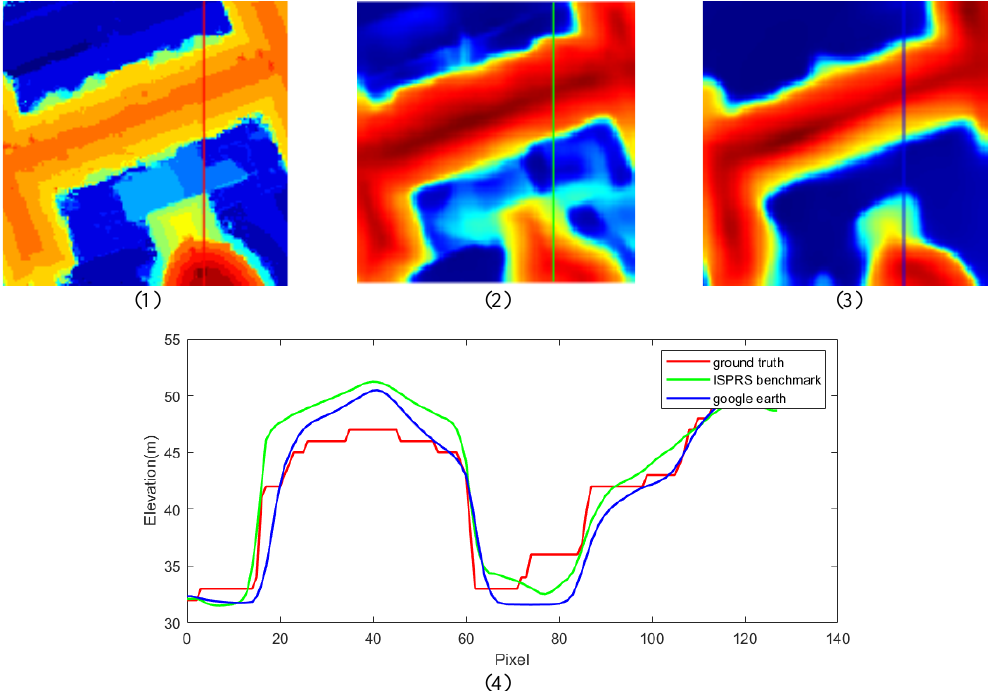
Figure 5 . The comparative results in Example 2: (1) Ground-truth image, (2) ISPRS benchmark, (3) Google earth image, (4) The 3 different